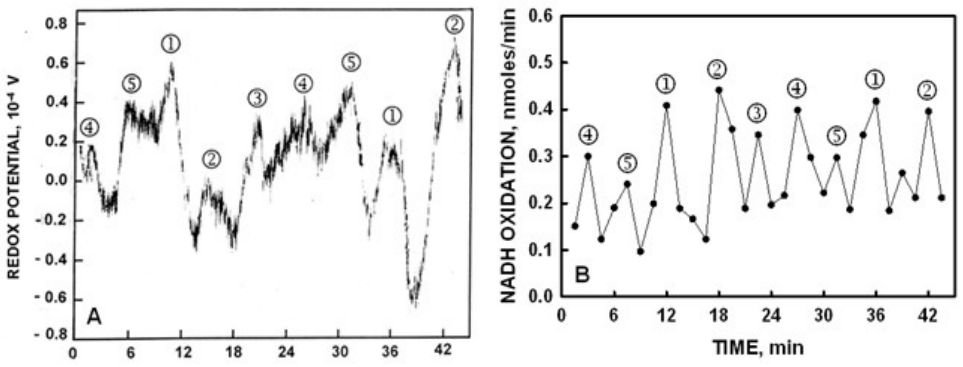
Figure 8. The redox potential ( A ) of an aqueous solution of copper chloride measured continuously showing a 2 + 3 pattern of oscillation with NADH oxidation measured over 1 min at intervals of 1.5 min ( B ) in parallel. The period length of both is 24 min. Results with pure water are similar except that the period length is now about 18 min.